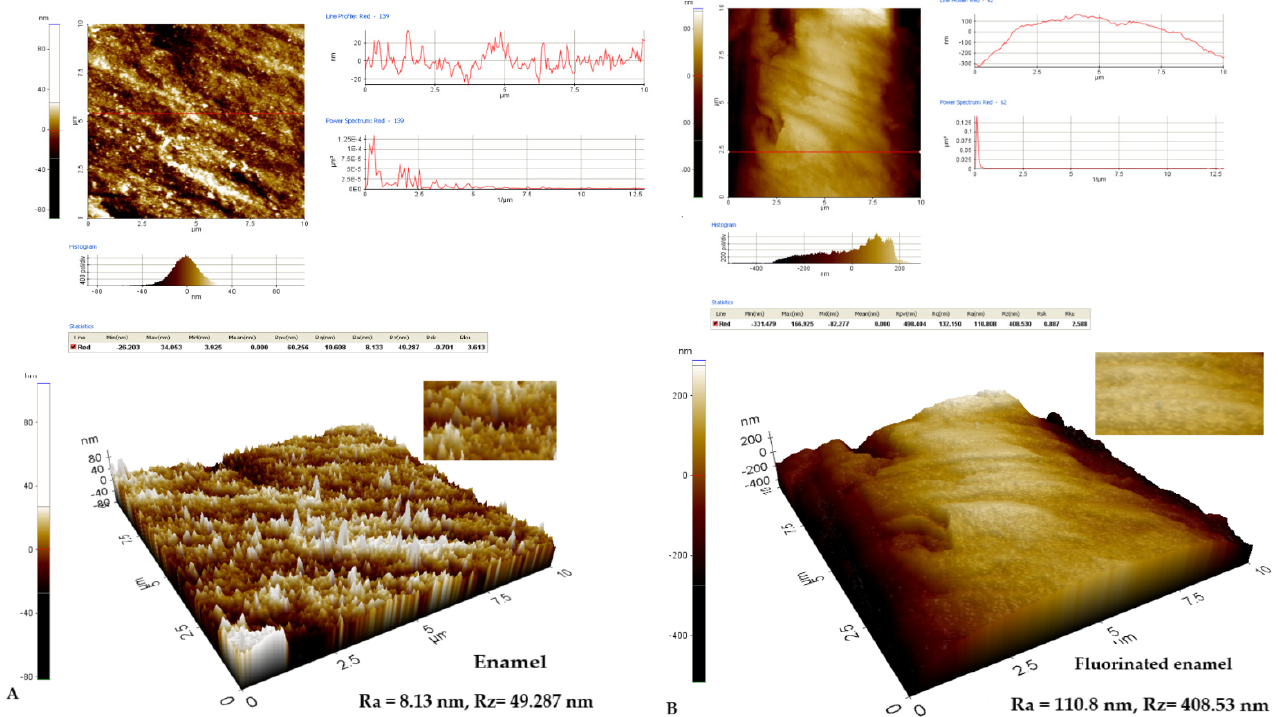
Figure 4. AFM images from the enamel surface layer on the X Scan layer 10 µ m/Y Scan layer 10 µ m: ( A ) Two-dimensional and three-dimensional AFM image of the enamel structure in the enamel without fluoridation Ra = 8.13 nm and Rz = 49.287 nm; ( B ) Two-dimensional and three-dimensional AFM image of the enamel structure in the enamel after fluoridation with varnish Ra = 110.8 nm and Rz = 408.53 nm.